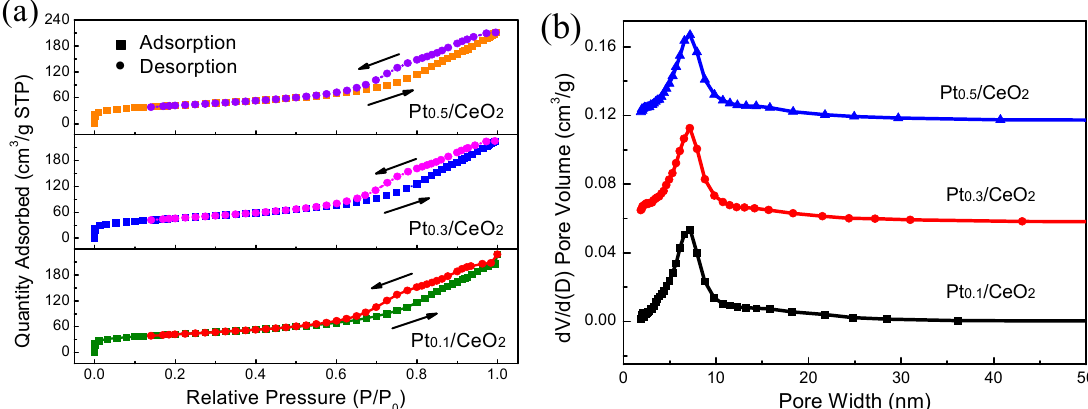
Figure 4. ( a ) Nitrogen adsorption–desorption isotherms and ( b ) the Barrett–Joyner–Halenda (BJH) pore size distributions of dealloyed Al 91.9 Ce 8 Pt 0.1 , Al 91.7 Ce 8 Pt 0.3 and Al 91.5 Ce 8 Pt 0.5 nanorod frameworks calcined at 300 °C.